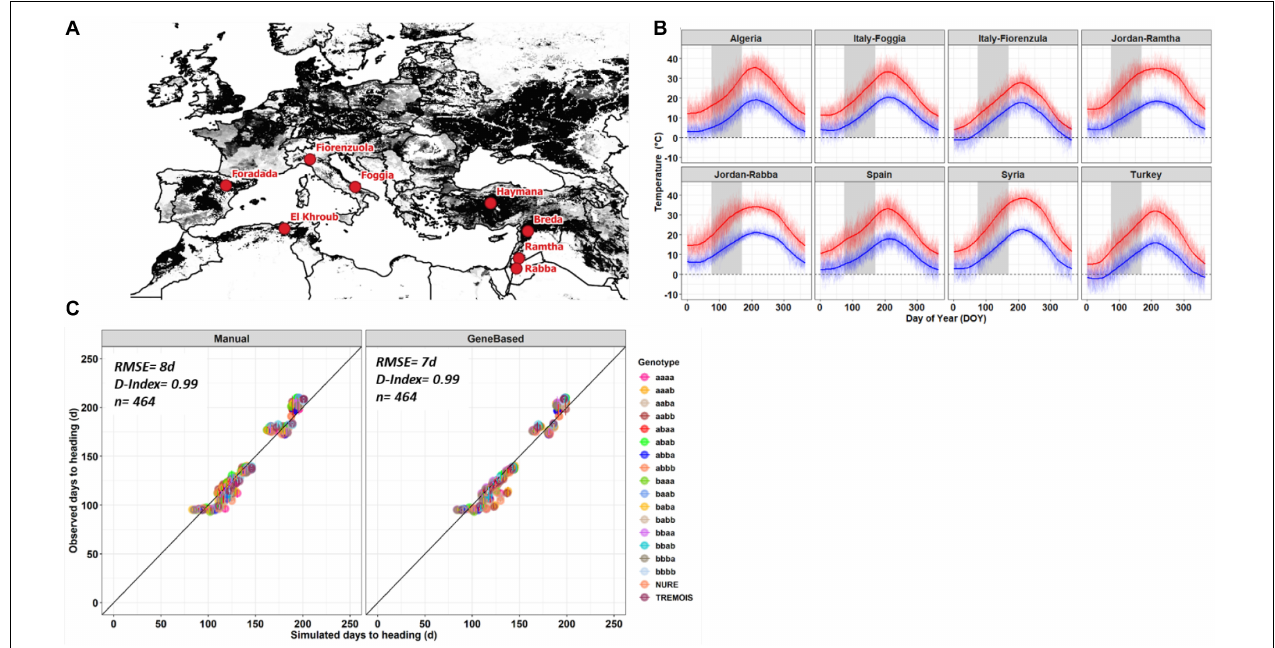
FIGURE 1 | (A) Barley growing area in the Mediterranean basin (gray scale area) and the eight locations (red dots), where, the barley genotypes were grown. (B) Maximum (red line) and minimum (blue line) air temperature at each location, the gray area represents the heading dates window simulated using long-term weather data. (C) Manual (left panel) and gene-based (right panel) fit against observed heading dates for each of the eighteen genetic types. Error bars represent the standard deviation of number of days across the replicates and the lines used for each allelic